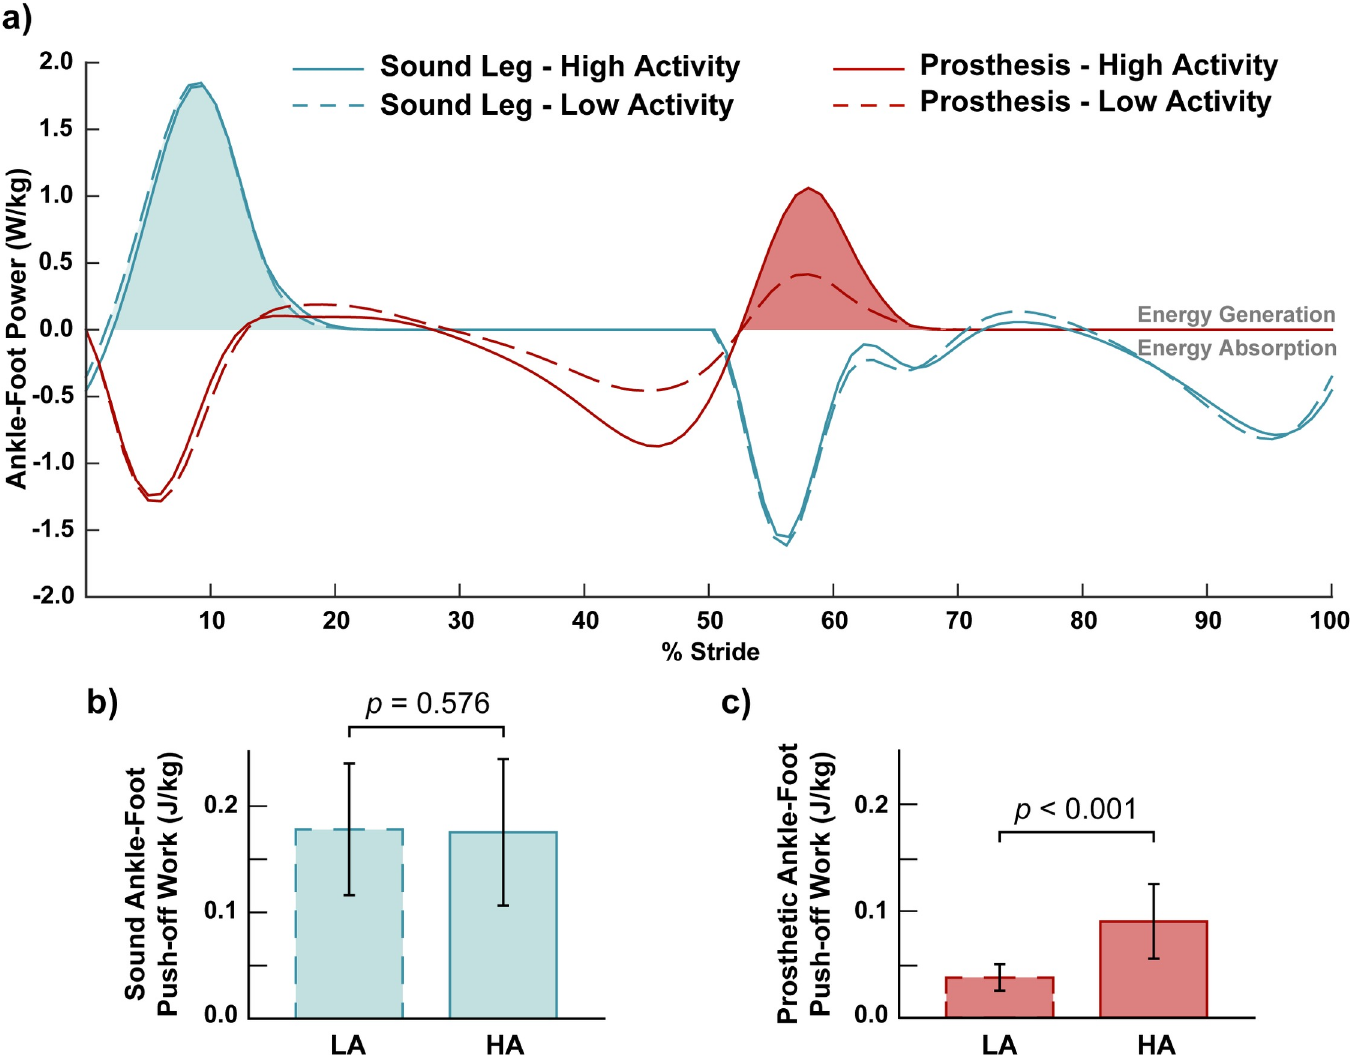
Fig 2. Prosthesis push-off work was 140% greater in the High Activity (HA) prostheses compared to the Low Activity (LA) prostheses (p < 0.001). Sound limb push- off work showed no significant difference between the two prosthesis conditions (p = 0.576). The late-stance positive power was integrated (a, shaded regions) to determine push-off work from the sound (b) and prosthetic (c) ankle-foot structures during overground walking. This process was completed for each of four limb conditions: sound limb, contralateral to low activity prosthesis (blue, dashed line); sound limb, contralateral to high activity prosthesis (blue, solid line); prosthetic limb, low activity prosthesis (red, dashed line): prosthetic limb, high activity prosthesis (red, solid line).